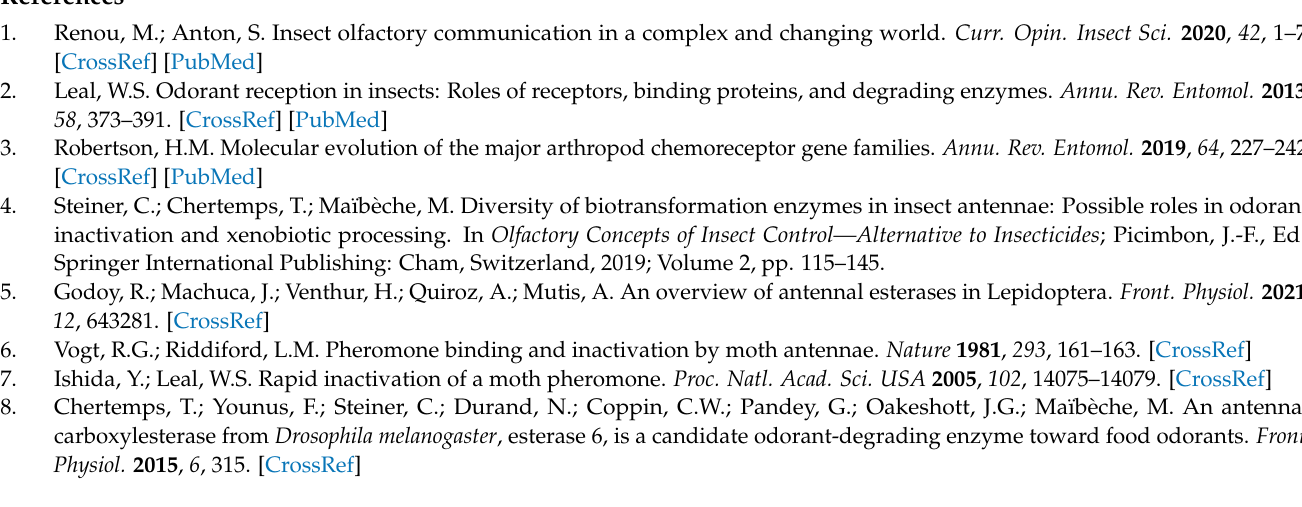
unigene assembly, Figure S2. KOG classification of the O. furnacalis unigenes, Figure S3. KEGG classification of the O. furnacalis unigenes, Figure S4. Catalytic motifs of the O. furnacalis CCEs, Figure S5. Predicted glutathione binding sites (G-sites) and substrate binding sites (H-sites) of the O. furnacalis GSTs, Figure S6. Functional domains of the O. furnacalis CYPs, Figure S7. Alignment of the functional domains of O. furnacalis UGTs, Table S1. GenBank accession numbers of genes used in phylogenetic analyses, Table S2. Primers used in RT-qPCR, Table S3. Putative odorant-degrading enzymes identified in O. furnacalis